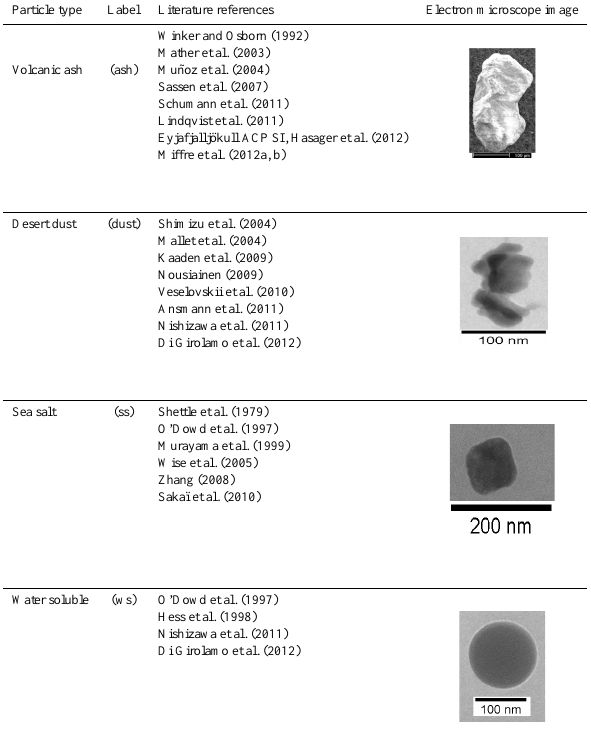
Table 1. Electron microscope images of volcanic ash, desert dust, sea-salt (ss) and water-soluble (ws) particles (an ammonium sulfate particle is observed) taken at ILM. In this paper, ws-particles are Table 1 1 Electron microscope images of desert dust particles, sea-salt (ss) particles and water-soluble 2 assumed spherical (s-particles). For volcanic ash, in the absence of Electron microscope images of desert dust particles, sea-salt (ss) particles and water-soluble 2 (ws) particles (an ammonium sulphate particle is observed) taken at ILM. In this paper, ws-3 measurement at the ILM, the image has been provided by O. Mu˜noz (ws) particles (an ammonium sulphate particle is observed) taken at ILM. In this paper, ws-3 particles are assumed spherical (s-particles). For volcanic ash, in the absence of measurement 4 particles are assumed spherical (s-particles). For volcanic ash, in the absence of measurement 4 from the Mount Spurr volcanic eruption. at the ILM, the image has been provided by O. Muñoz from Mount Spurr volcanic eruption. Table 1 1 at the ILM, the image has been provided by O. Muñoz from Mount Spurr volcanic eruption. 5 Electron microscope images of desert dust particles, sea-salt (ss) particles and water-soluble 2 (ws) particles (an ammonium sulphate particle is observed) taken at ILM. In this paper, ws-3 particles are assumed spherical (s-particles). For volcanic ash, in the absence of measurement 4 at the ILM, the image has been provided by O. Muñoz from Mount Spurr volcanic eruption. 5